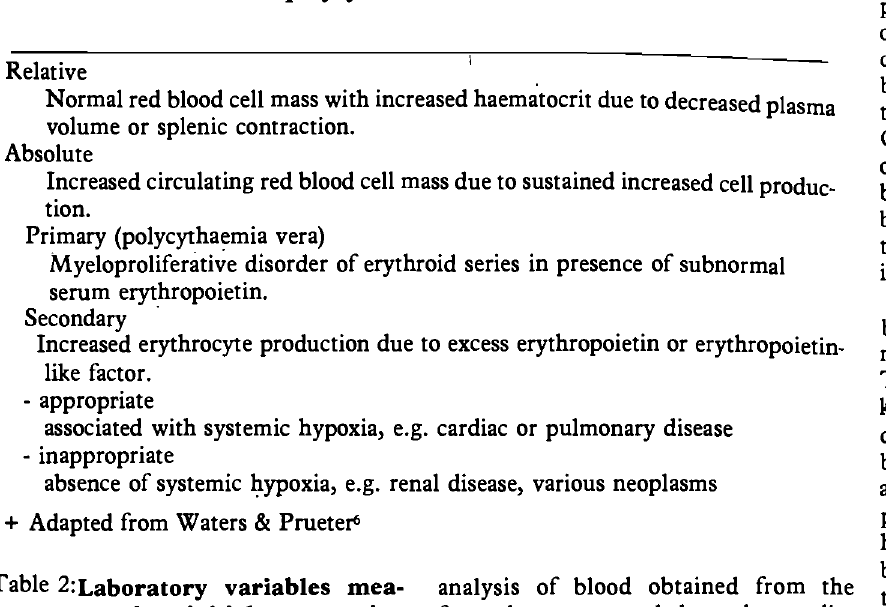
Table 2:Laboratory variables mea sured on initial presentation of a case of polycythaemia